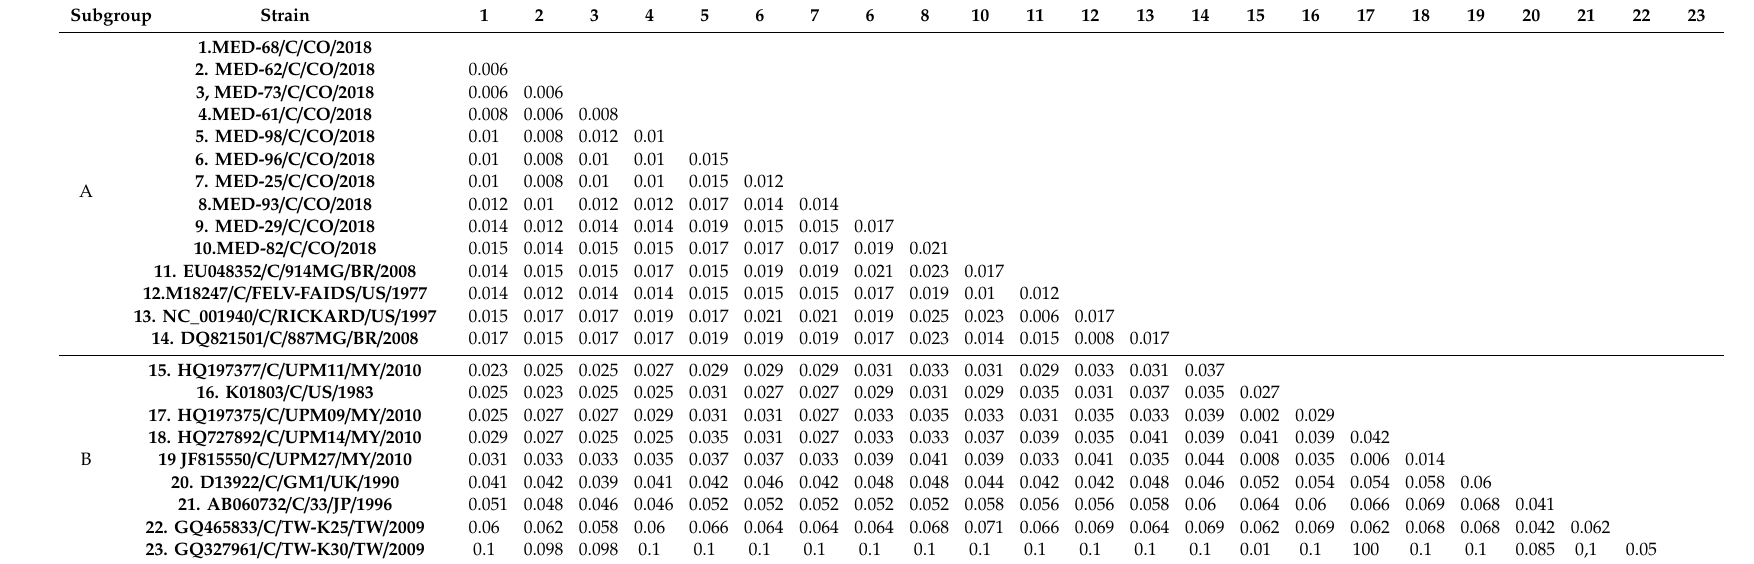
Table 4. Distances (amino acids) from the GAG region of FeLV. The most representative sequences in the Aburr á Valley and their distance with reference strains of the FeLV-A and FeLV-B subgroups are